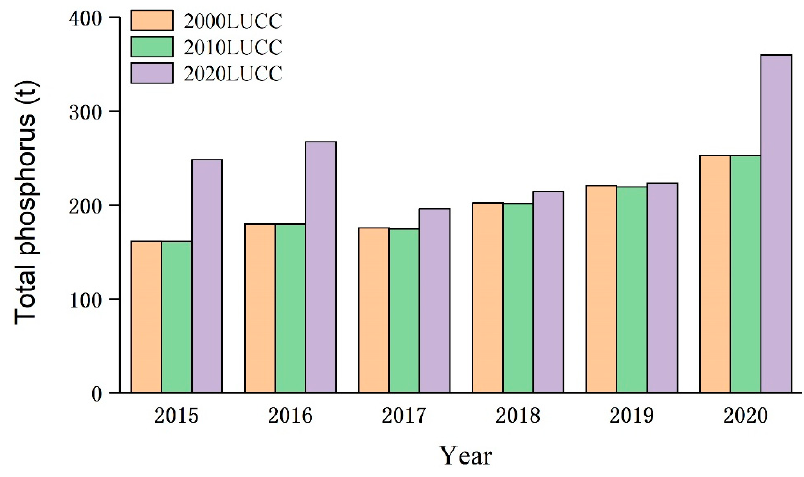
Figure 19. Annual load of total phosphorus under three land use phases.